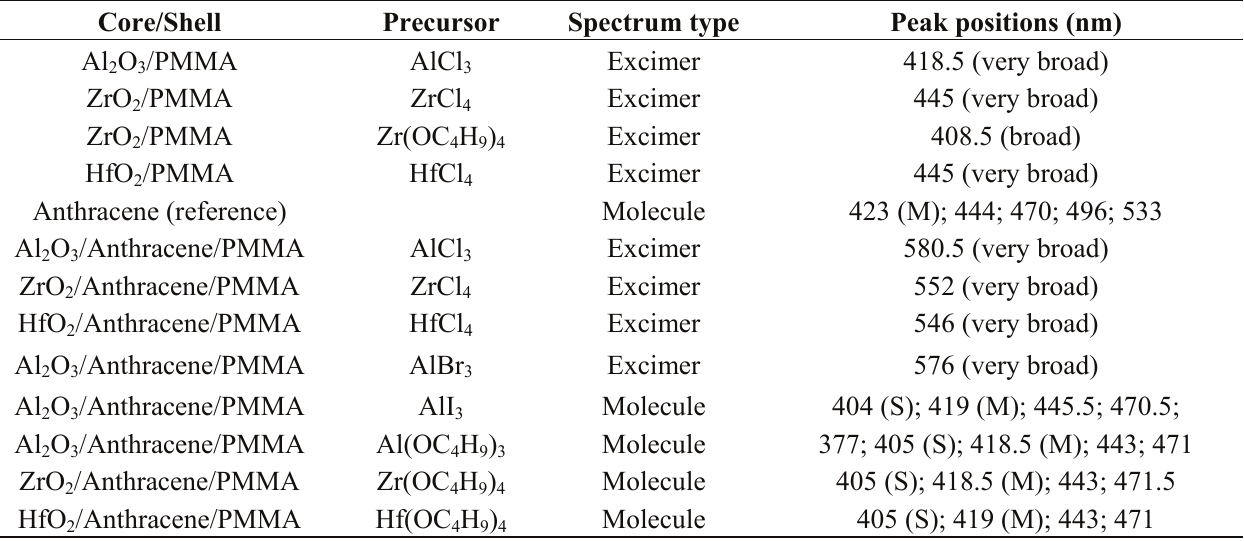
Table 8. Luminescence properties of various core/shell nanoparticles made from halides or organometallic precursors